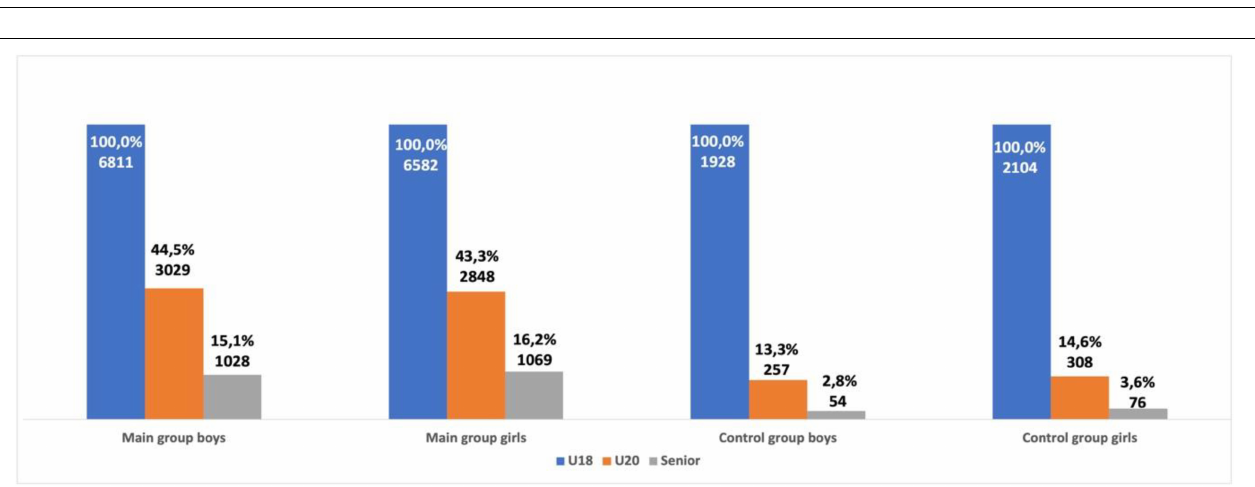
FIGURE 6 | The number of successful U18 and U20 female athletes as a senior in group one and group two.